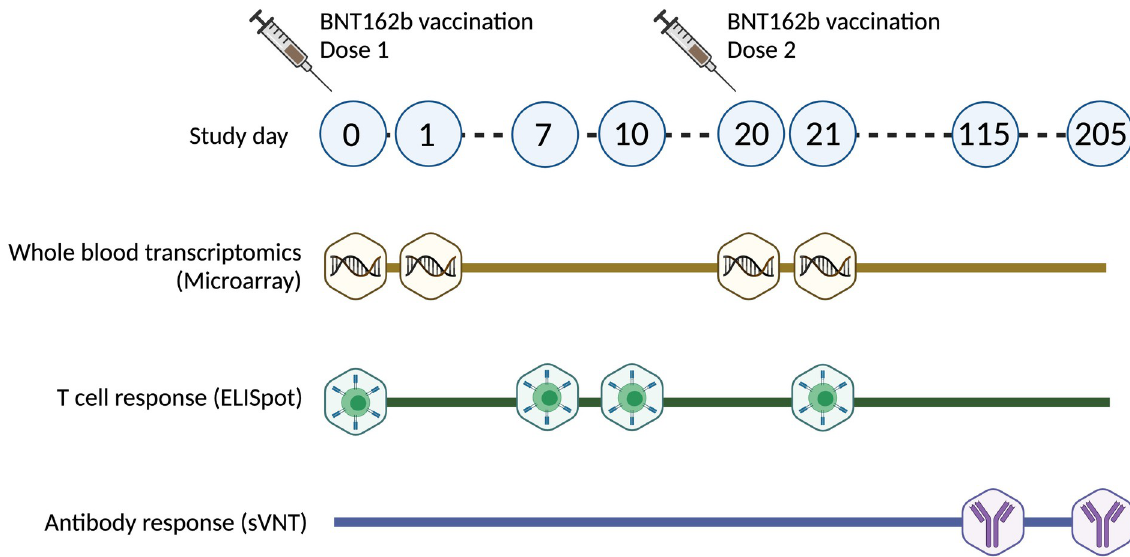
Fig 1. Overview of study design. Timeline of dose 1 and dose 2 vaccination and sample collection for gene expression studies, T-cell, and antibody response analysis. sVNT, surrogate virus neutralization test.